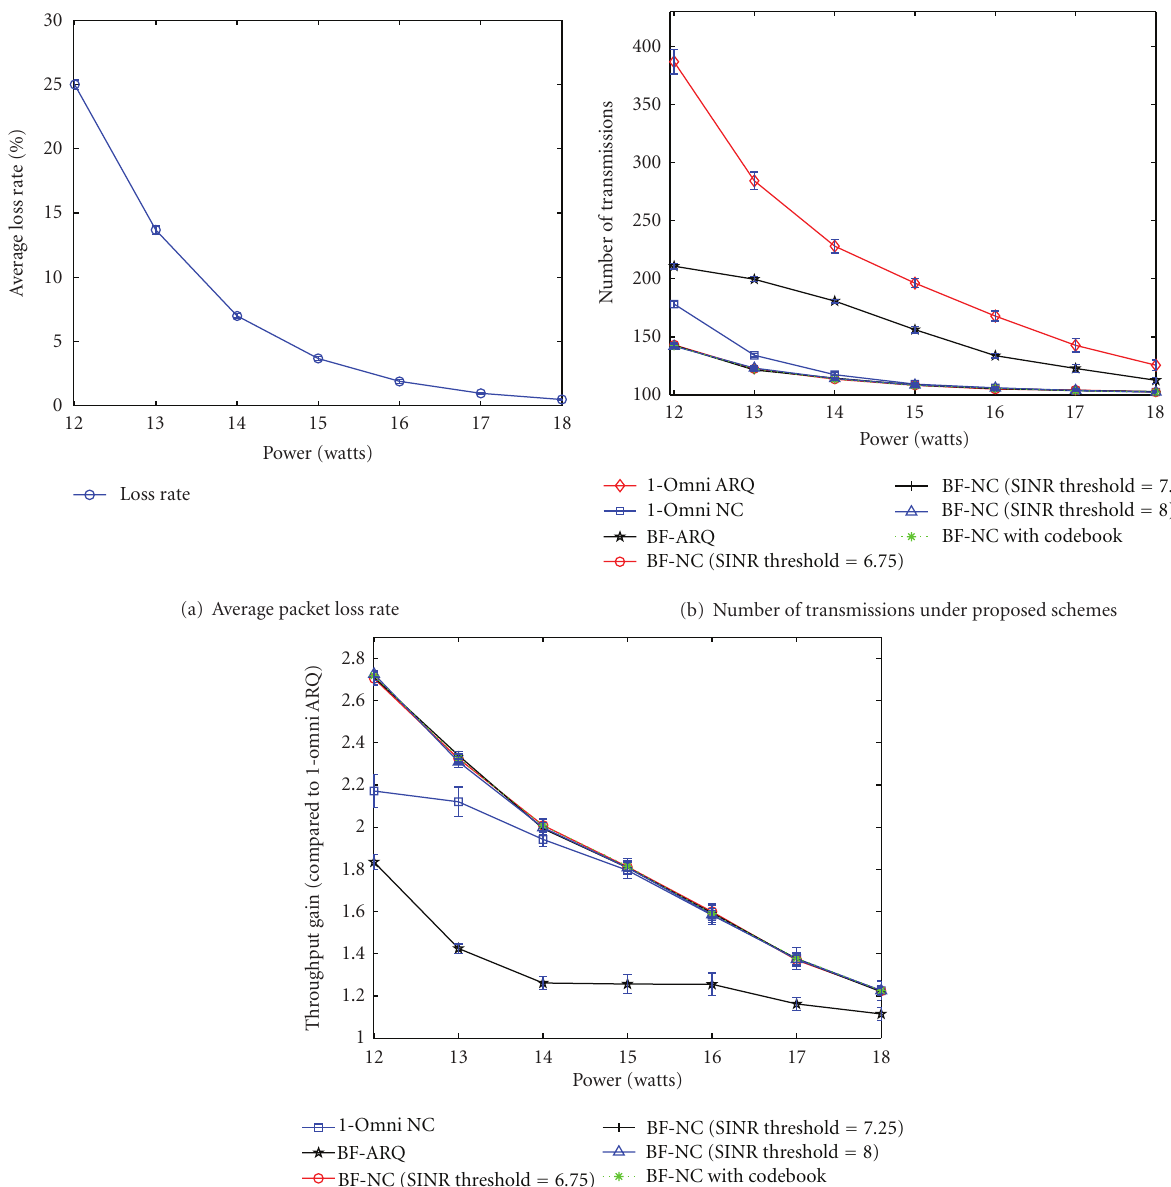
Figure 9: Simulation results for network topology scenario of Figure 7(b) with 60 MSs formed into 3